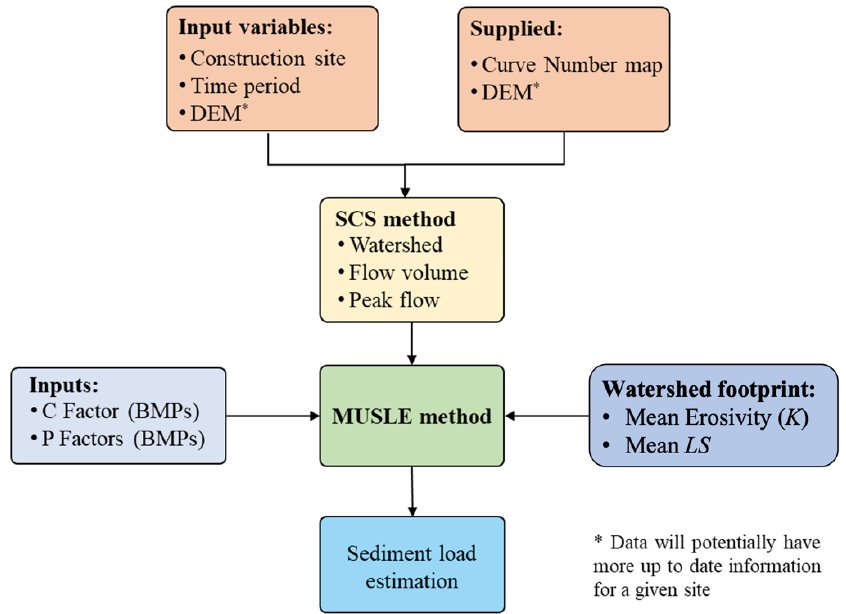
Figure 1. Overland erosion model input flowchart.